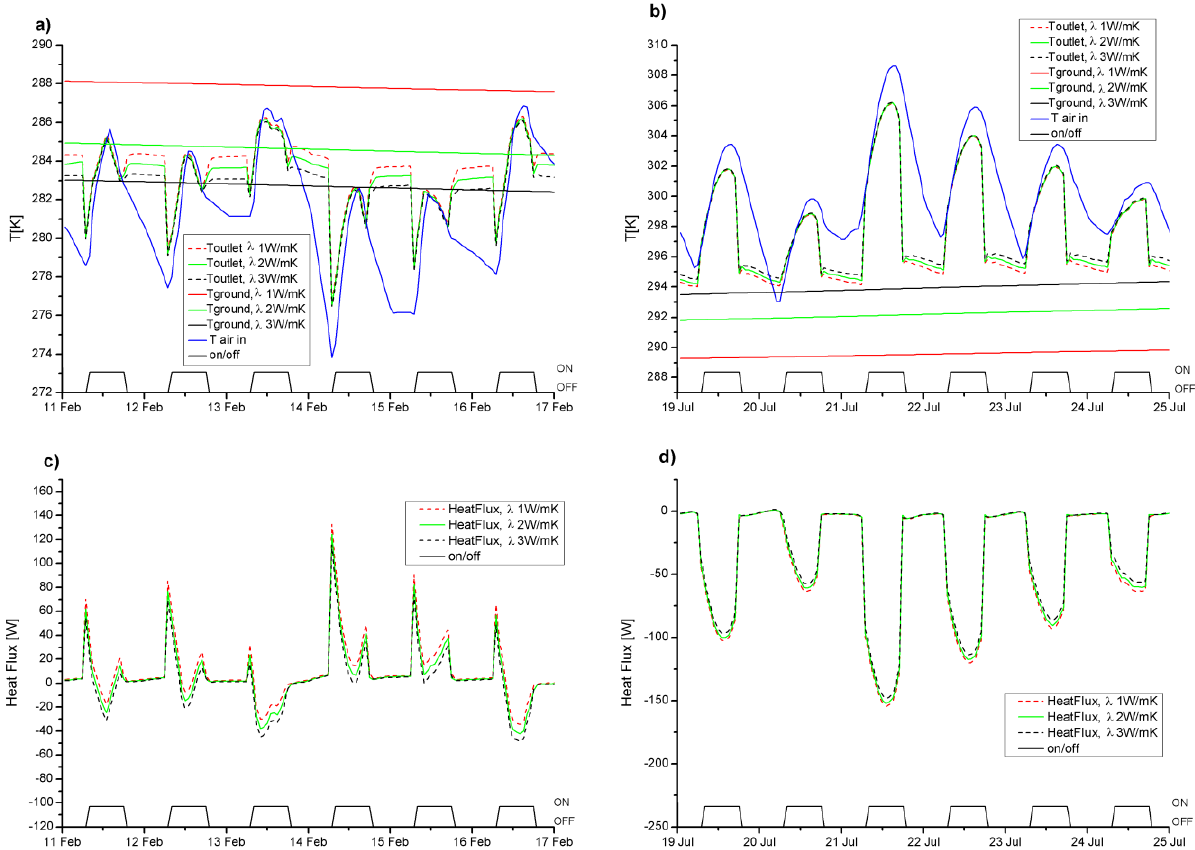
Figure 15. Inlet-outlet air temperatures, air-ground thermal power varying the soil conductivity λ = 1–3 W/m K, fixed air flow rate 350 m 3 /h, for typical winter ( a , c ) and summer weeks ( b , d